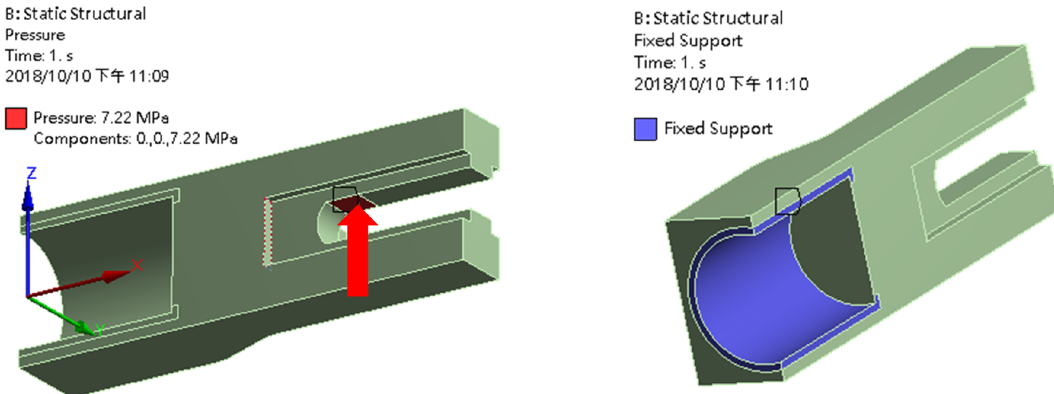
Figure 16. Fastener, with the restrained and application ends, respectively.